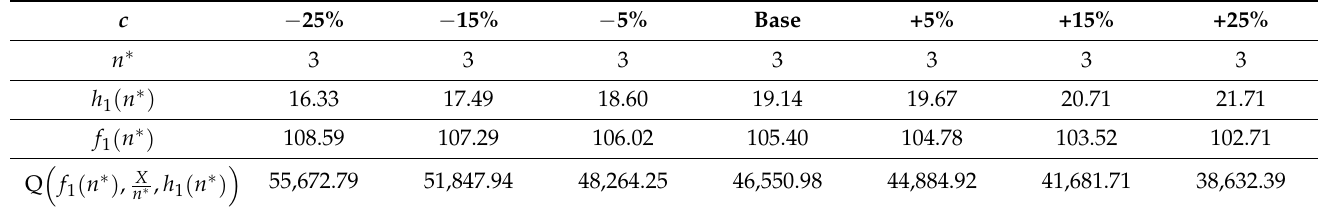
Table 5. Variation of the bus operating cost c